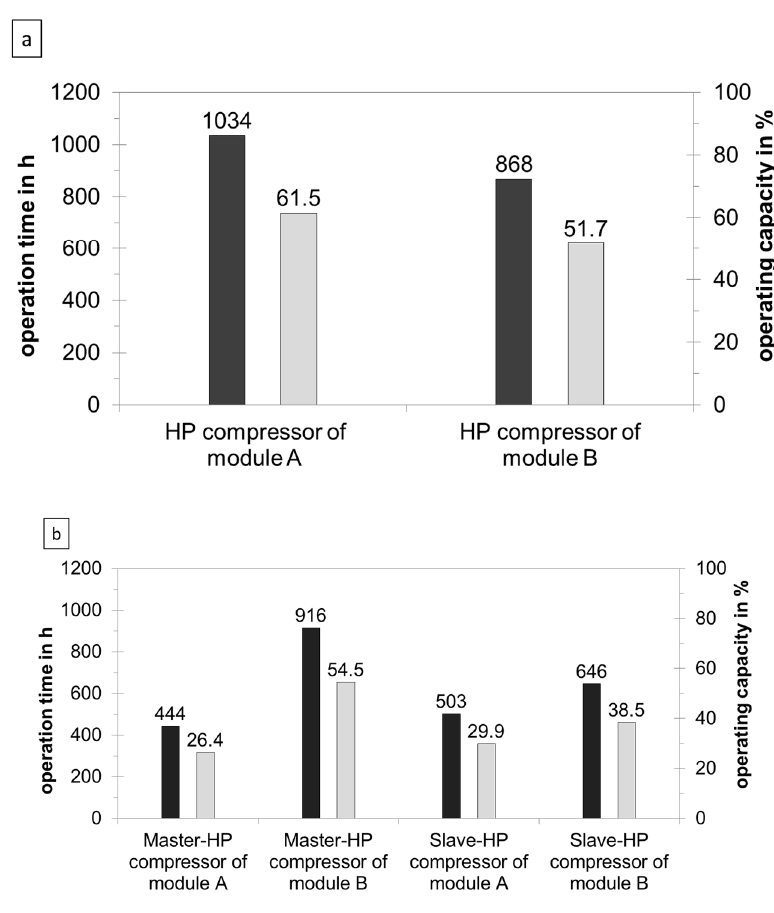
Figure 5. Operating hours (black column) and operating capacity (grey column) of ( a ) heat pump compressors in the farrowing barn and ( b ) piglet-rearing barn during the 70-day trial period, which correspond 1680 h.